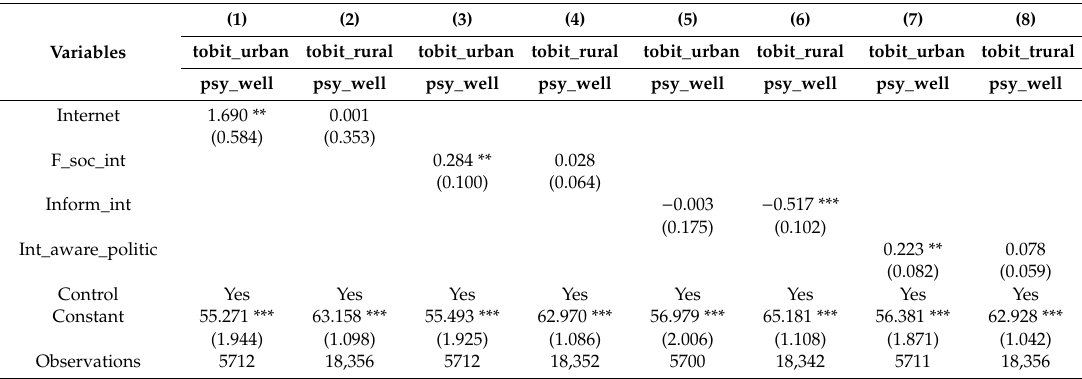
Table 8. Robustness test using the Tobit